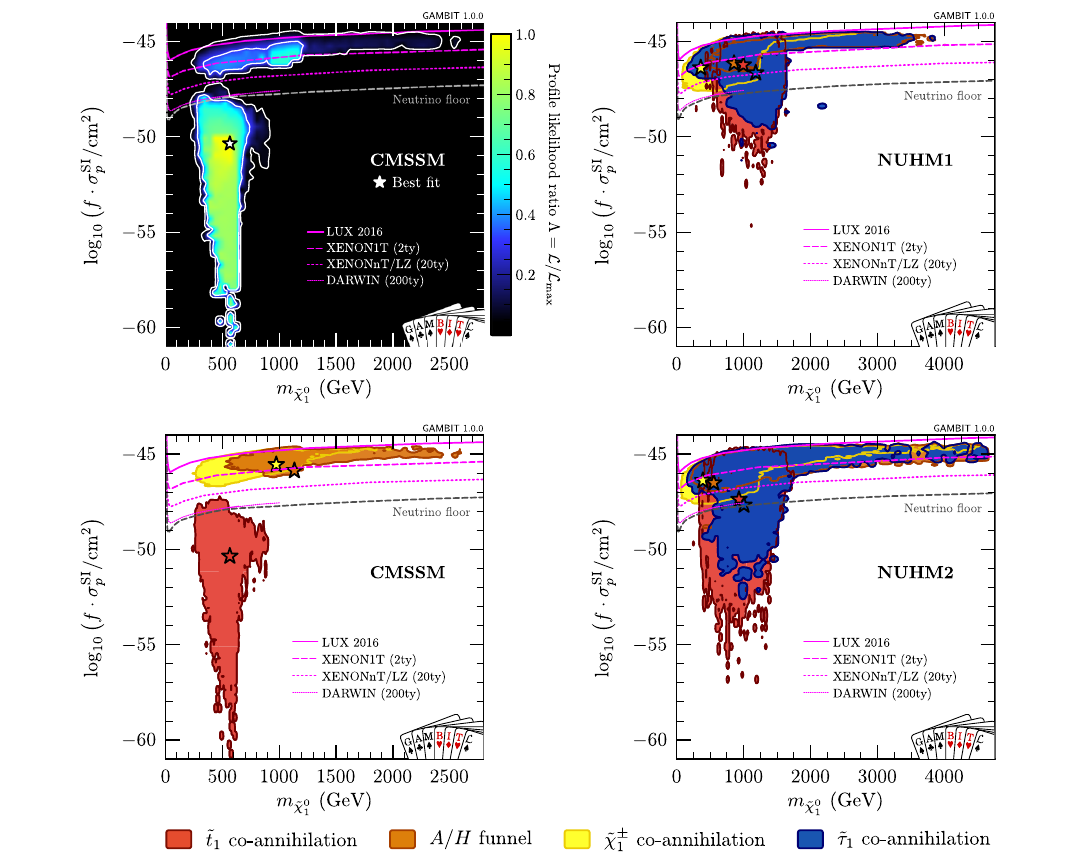
Fig. 18 Left: Profile likelihood for the NUHM2 in the ˜ χ ± plane. Right: Colour-coding shows mechanism(s) that allow models within the 95% CL region to avoid exceeding the observed relic density